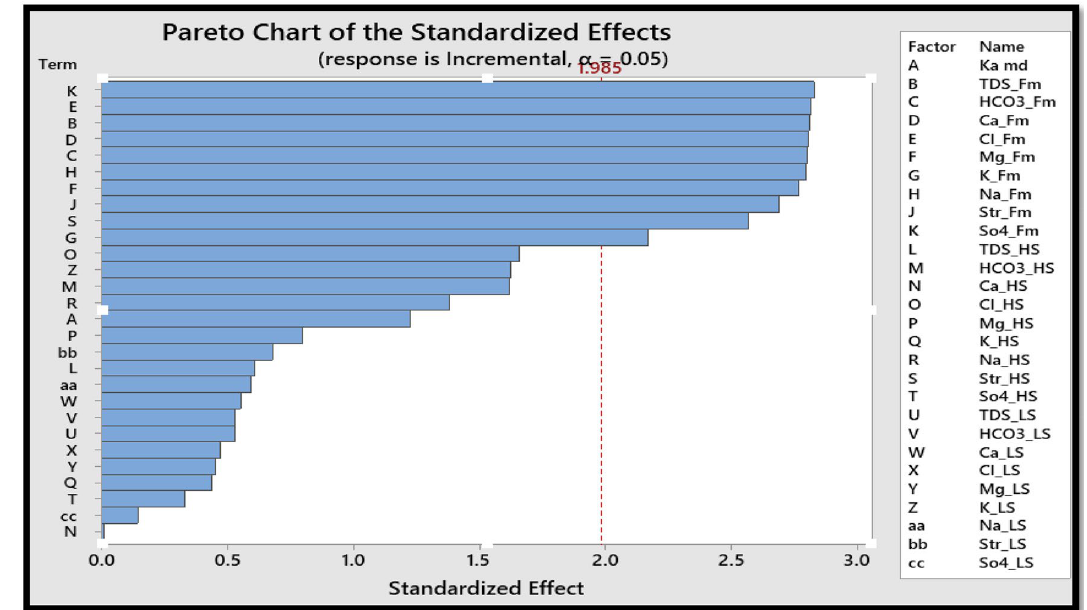
Fig. 12 Pareto chart using the datasets (without considering clay properties) of the tertiary